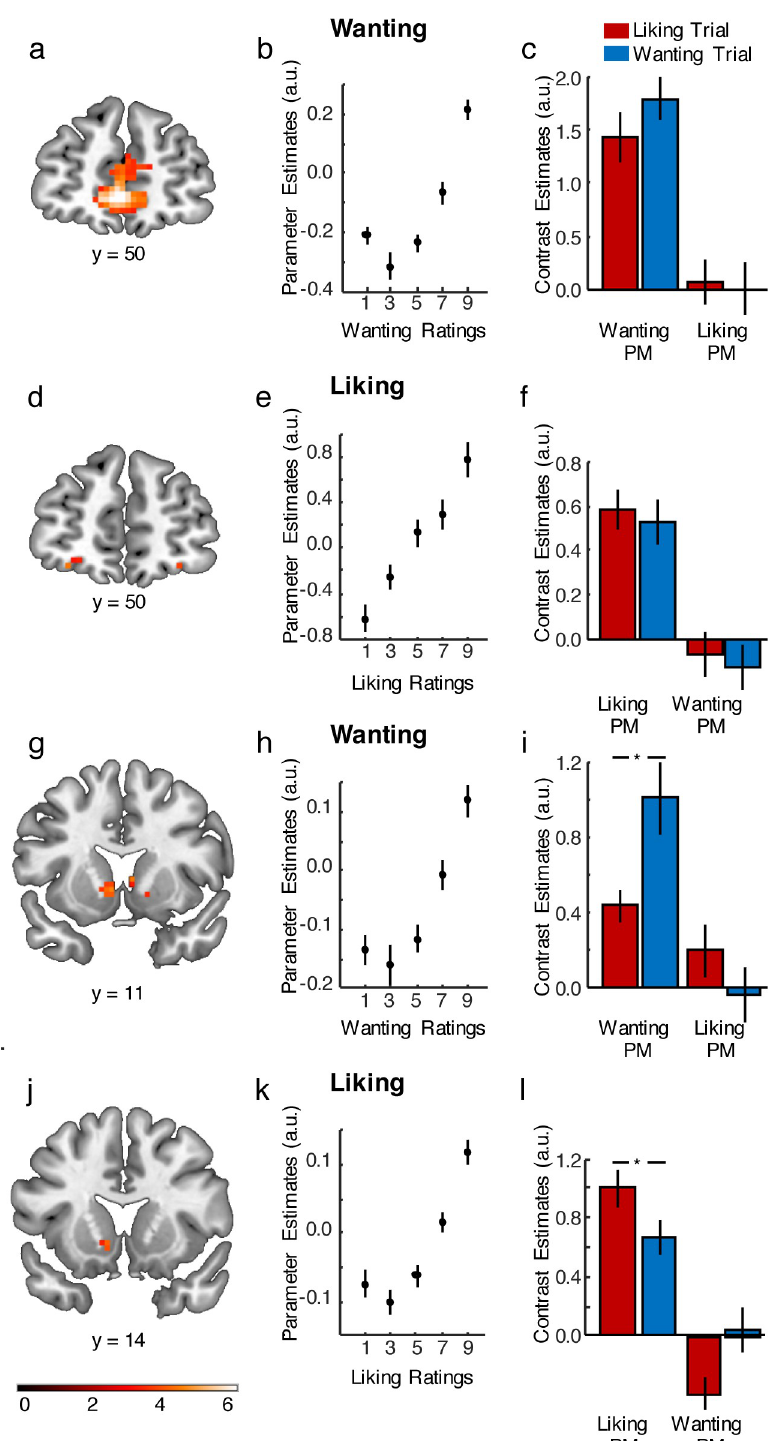
Fig 2. Neural encoding of motivational and hedonic reward dimensions. A–B. Wanting ratings correlated with activity in the mPFC. C . Contrast estimates for the wanting and liking PMs show that correlation of mPFC activity with wanting ratings was stronger than with liking ratings and occurred irrespective of which judgment was expressed in behavior. D–E. Liking ratings correlated with activity in the central OFC. F . The correlation of central OFC activity with liking ratings was stronger than with wanting ratings and occurred irrespective of judgment type. G–H .